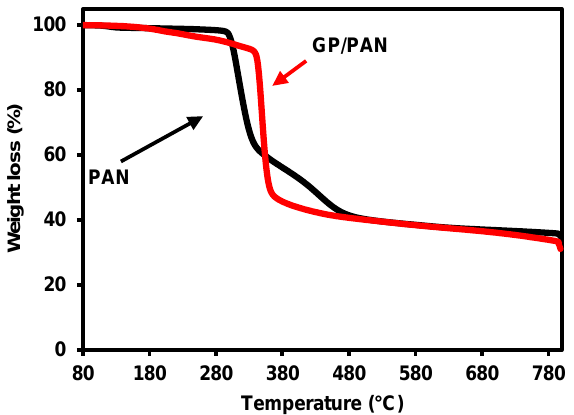
Figure 8. Thermogravimetric curves of polyacrylonitrile (PAN) and graphene oxide modified by polydiallyldimethylammonium chloride/polyacrylonitrile (GP10/PAN) hybrid nanofiber membranes.